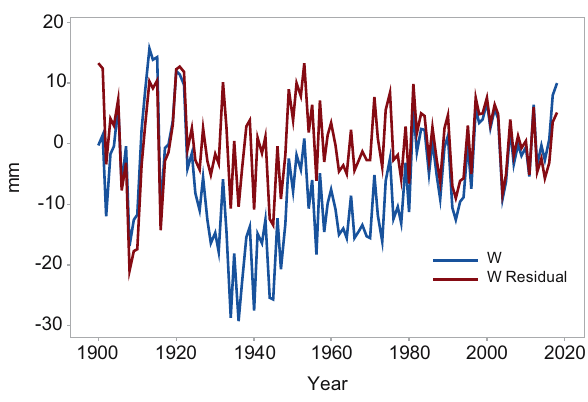
Figure 10: Misclosures and misclosure residuals are displayed. The RMS of the misclosures = 10.0 mm, reduced to 1.9 mm ( the RMSE of the misclosure residuals ) after modeling the linear trend and the periodic variations due to the luni - solar